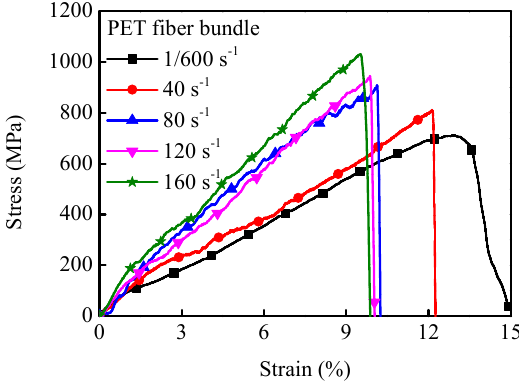
Figure 5. Tensile stress–strain curves of the PET fiber bundle at different strain rates.